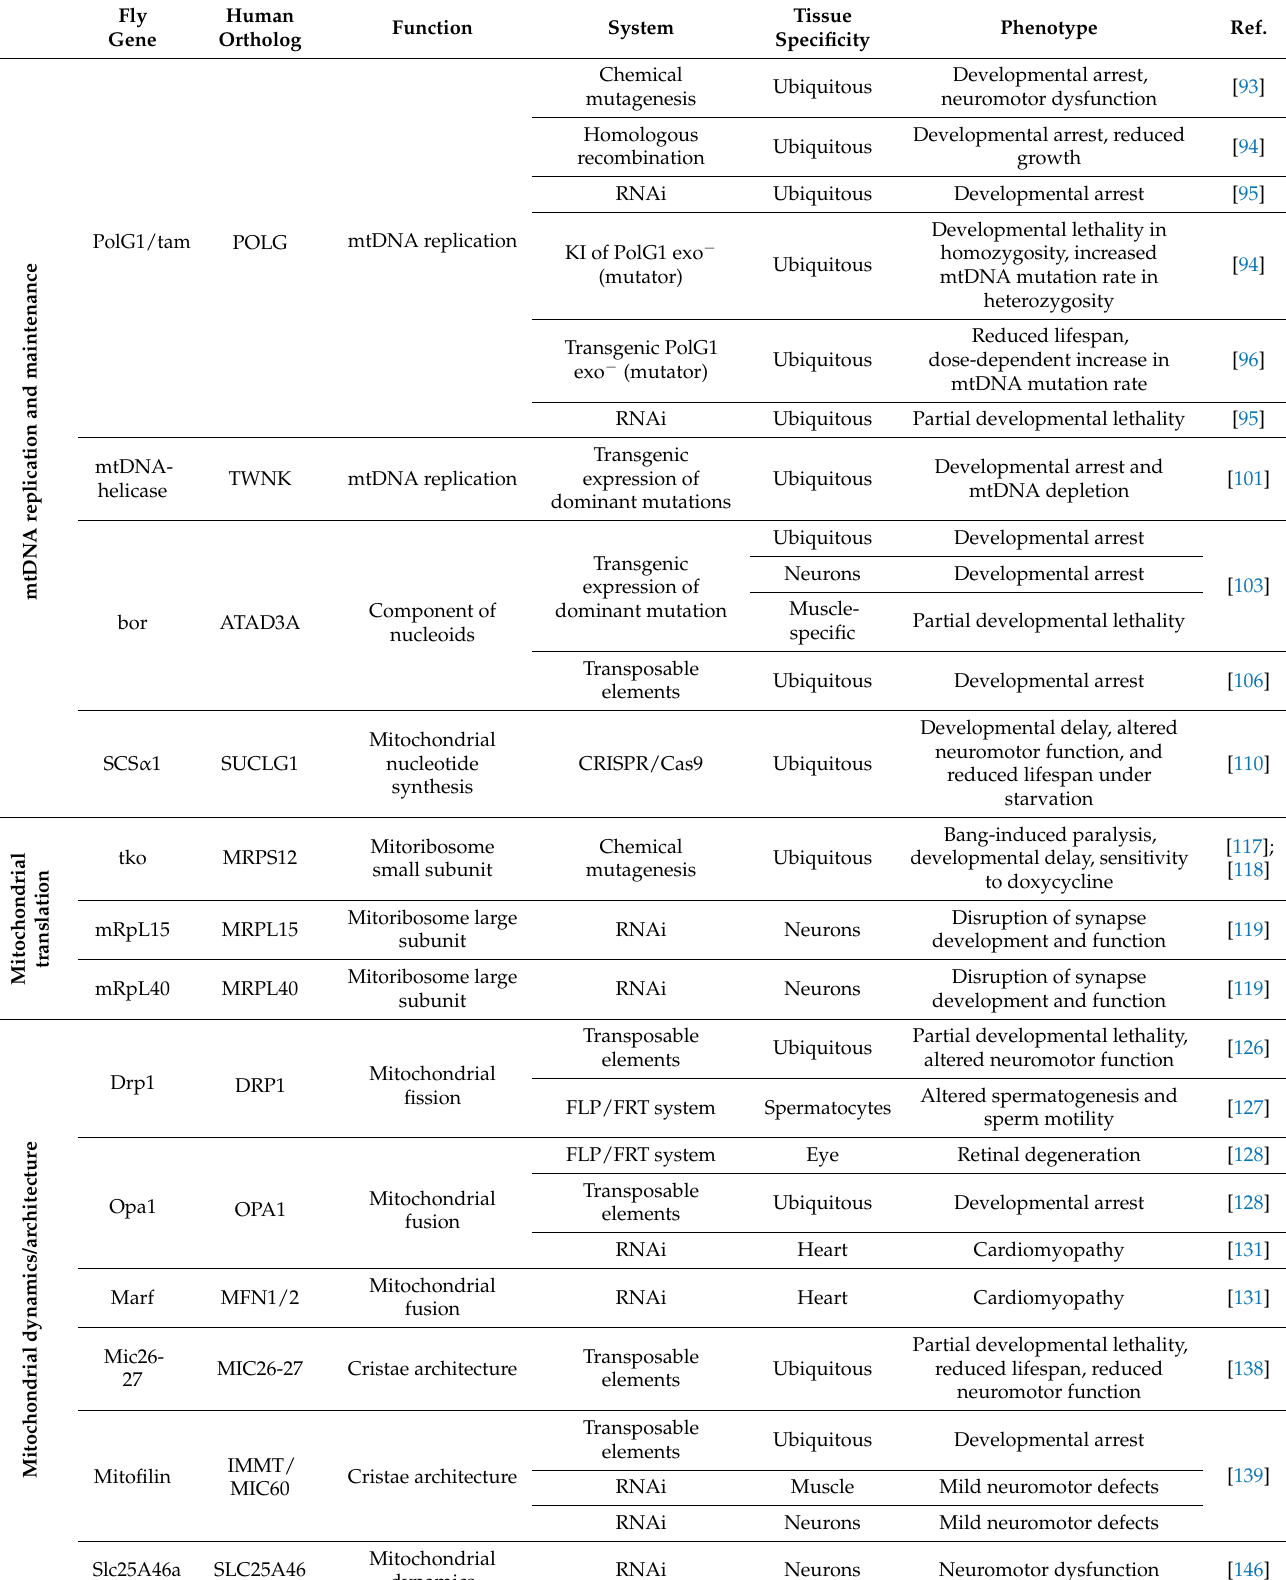
Table 2. Fly models of other mitochondrial